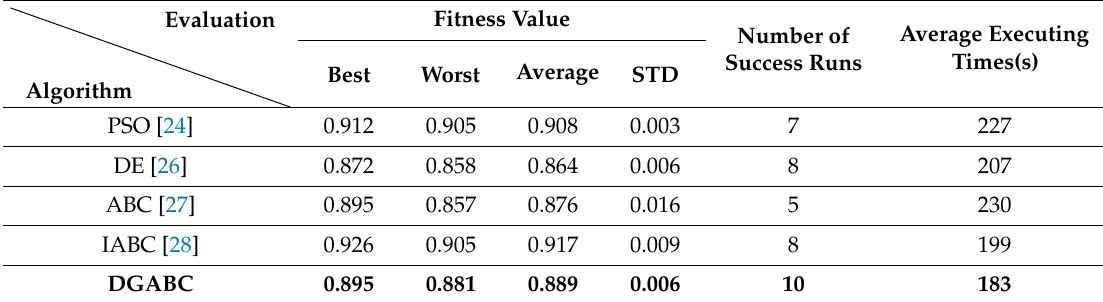
Table 2. Performance comparison of various